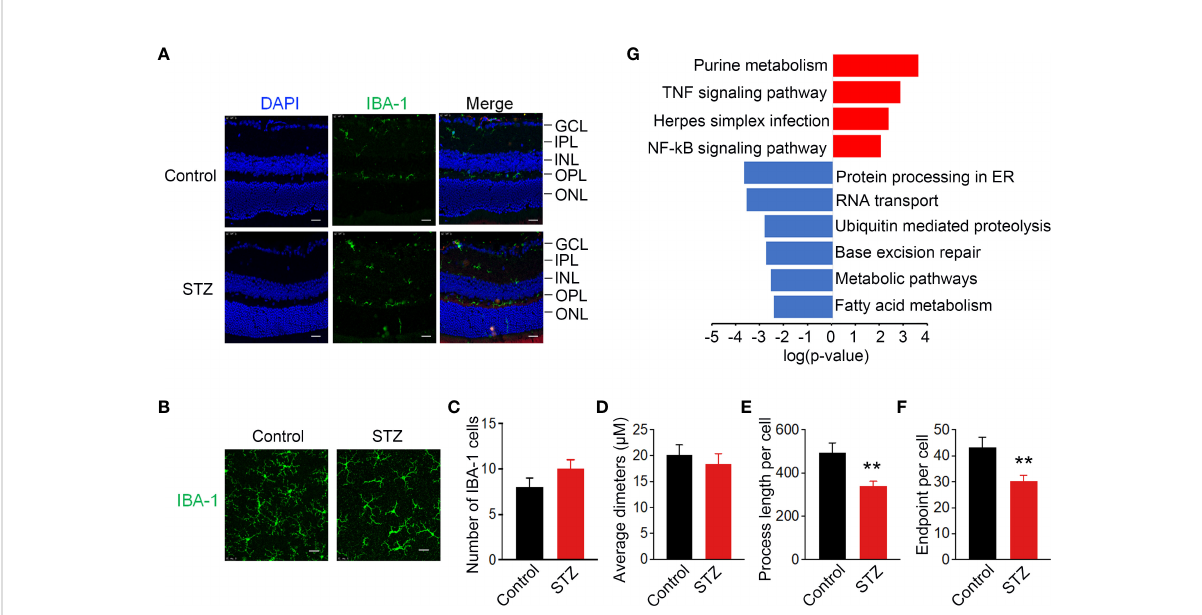
FIGURE 3 Activated retinal microglia in STZ-induced DR mice with metabolic and in fl ammatory disturbances. (A) Representative retinal cross sections of STZ stained with 6-Diamidino-2-Phenylindole (DAPI) (blue) and IBA-1 (green) showed activated microglia translocation to the ONL. Scale bar indicates 100 m m. ONL, outer region of outer nuclear layer; OPL, outer plexiform layer; INL, inner region of outer nuclear layer; IPL, inner plexiform layer; GCL, ganglion cell layer. (B) Morphological changes in microglia immunolabelled for IBA-1 (green) in retinas of diabetic mice indicated activated microglia with shortened processes. Scale bar indicates 25 m m. (C – F) Summary data of the number of microglia per fi eld, average diameters of microglia, process length, and number of endpoints per cell. n = 3, **p < 0.01. (G) KEGG analysis identi fi ed metabolic and in fl ammatory-related pathways enriched in activated retinal microglia (ARM) according to the differentially expressed genes in cluster 36 from control and STZ retina. **p <